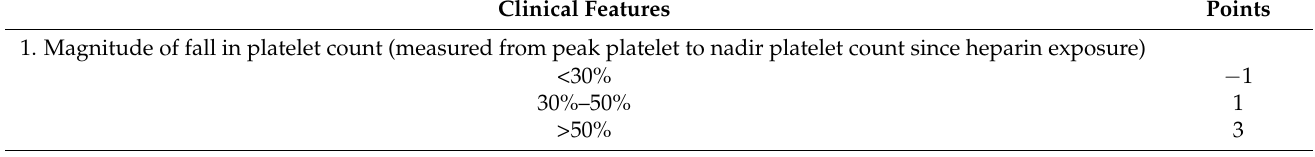
Table A2. Heparin-Induced Thrombocytopenia (HIT) Expert Probability score: the HEP score. Clinical